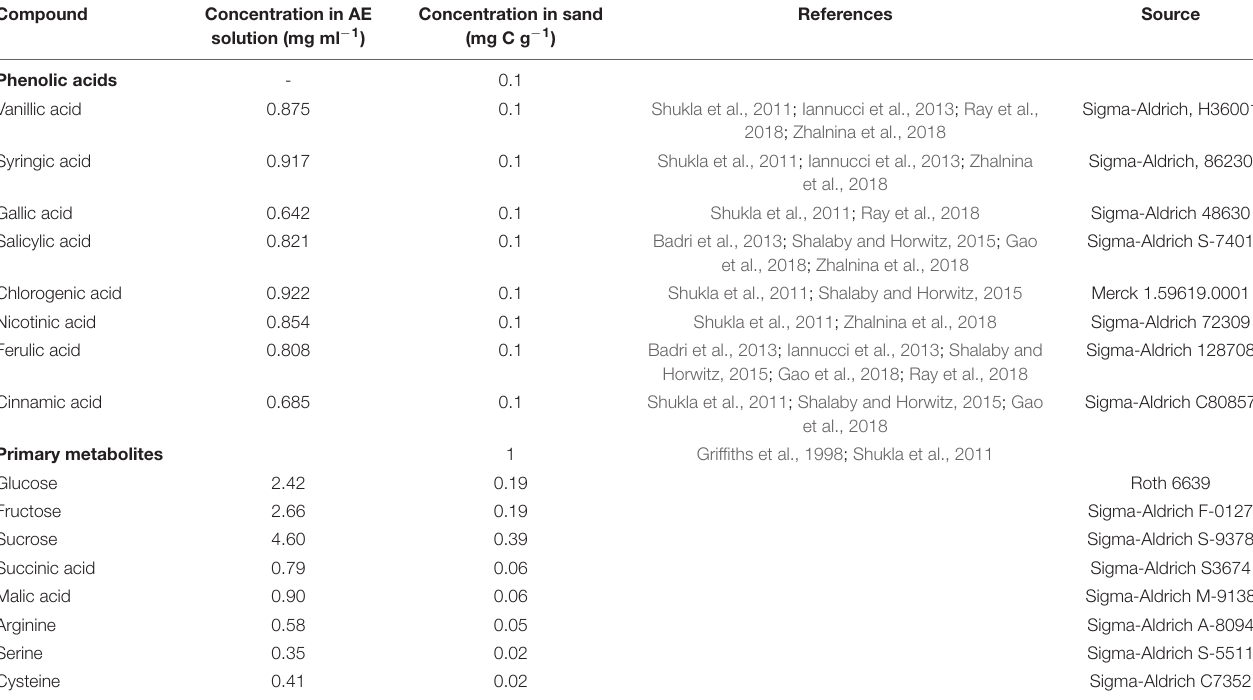
TABLE 1 | Phenolic acids and primary metabolites used in Exp.